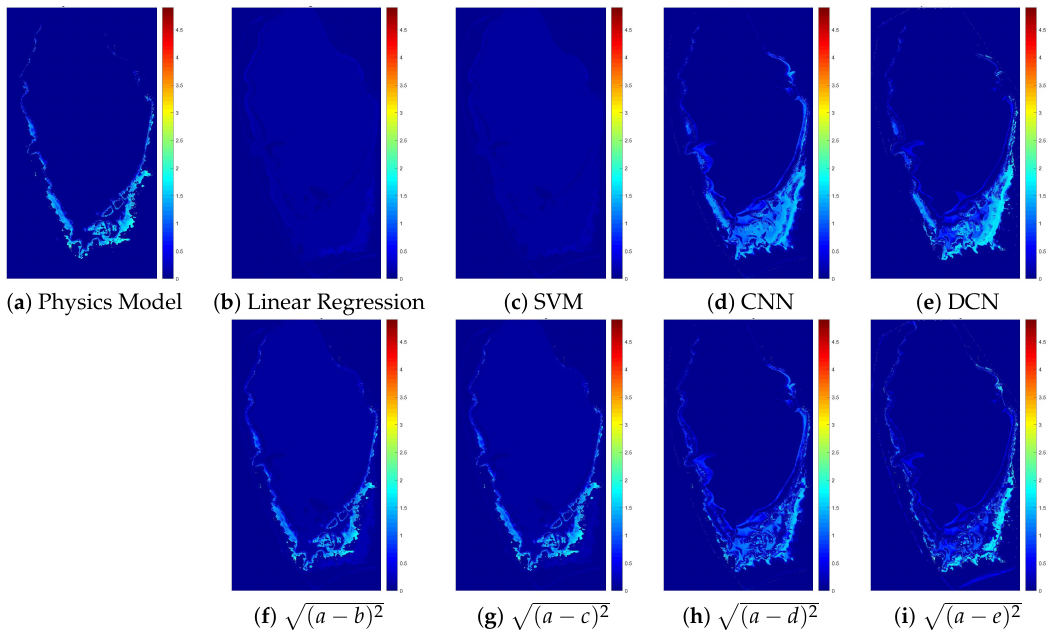
Figure 8. LAI mapping at St. Joseph Bay produced by models trained with patches from the selected regions. No mask was applied in this case.